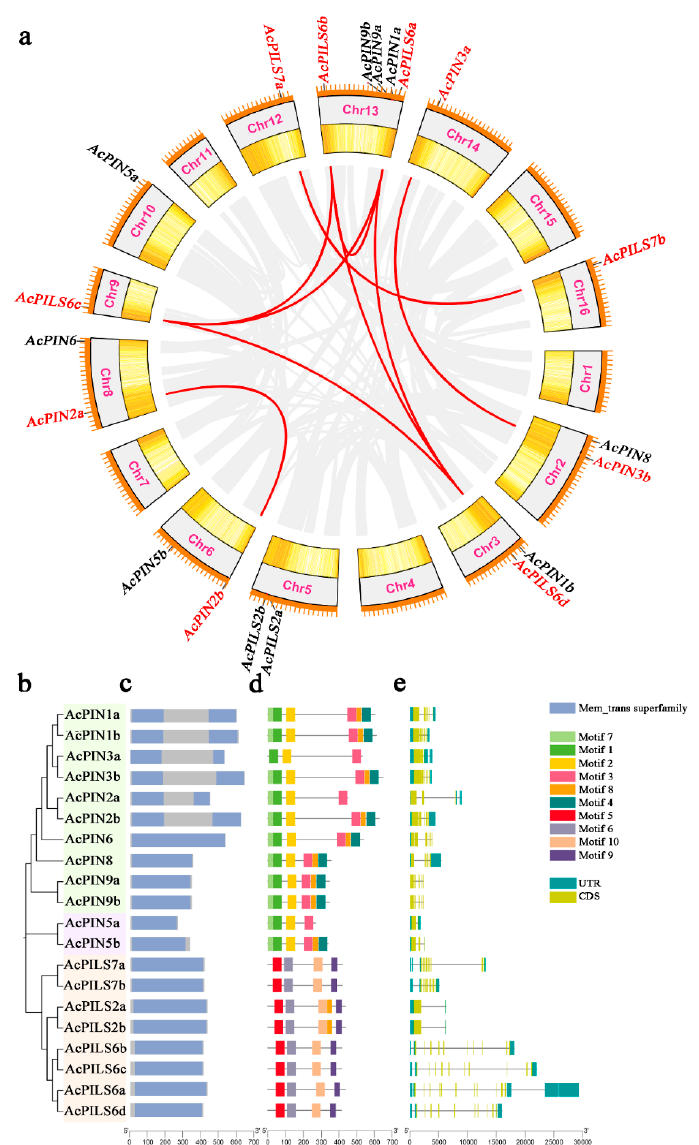
Figure 2. Synteny analysis and AcPIN / AcPILS gene structure and conserved motifs in Areca catechu . ( a ) Chromosomal locations and Synteny relationships of AcPIN / AcPILS genes. Colorful lines represent gene duplications. ( b ) Phylogenetic relationships. ( c ) Conserved protein domain. ( d ) Conserved motifs. The different colored boxes represent different motifs and their position in each AcPIN/AcPILS protein sequence. The scale bar indicates the number of amino acids. ( e ) Gene structure among PIN genes of A. catechu . The introns and exons are shown as black lines and yellow boxes, respectively. Atrovirens boxes represent the untranslated regions. The scale bar indicates number of nucleic acids